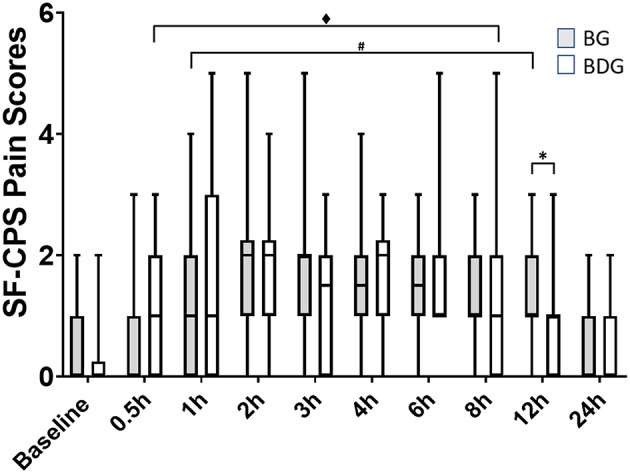
Pain scores. Boxplots showing the pain scores with median, interquartile range and minimum and maximum values, using the short form of the multidimensional composite pain scale (UNESP-Botucatu; SF-CPS). Pain scores correspond to a 12-point scale, where the cut-off score for administration of rescue analgesia was ≥4. BG, intraperitoneal bupivacaine (bupivacaine 0.25%, 2 mg/kg); BDG, intraperitoneal bupivacaine (bupivacaine 0.25%, 2 mg/kg) and dexmedetomidine (1 μg/kg). All cats received meloxicam (0.2 mg/kg SC) at 12 h postoperatively. Values of p < 0.05 were considered significant. *Significant difference between groups. #Significant difference when compared with baseline (BG). ♦Significant difference when compared with baseline (BDG).